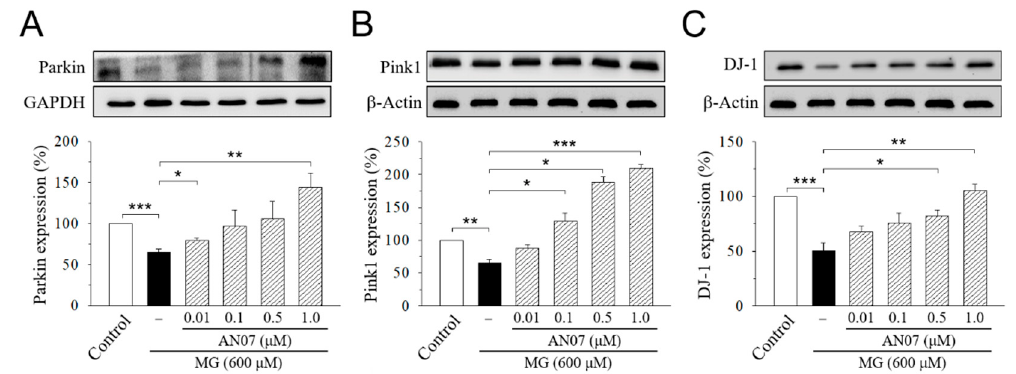
Figure 9. AN07 restores the down-regulation of Parkin ( A ), phosphatase and tensin homolog ( PTEN )-induced putative kinase 1 (pink1) ( B ), and DJ-1 (Parkinson disease protein 7, PARK7 ) ( C ) in methylglyoxal (MG)-treated SH-SY5Y cells. SH-SY5Y cells were pre-treated with AN07 (0.01–1.0 µ M) for 1 h and then exposed to 600 µ M MG for another 24 h. Upper panels, representative immunoblots. Lower panels, densitometry analyses of the relative ratio of protein / β -actin protein, represented as percentages of the control group. Columns, mean ± S.E.M. from at least three independent experiments. * p < 0.05, ** p < 0.01, *** p < 0.001.